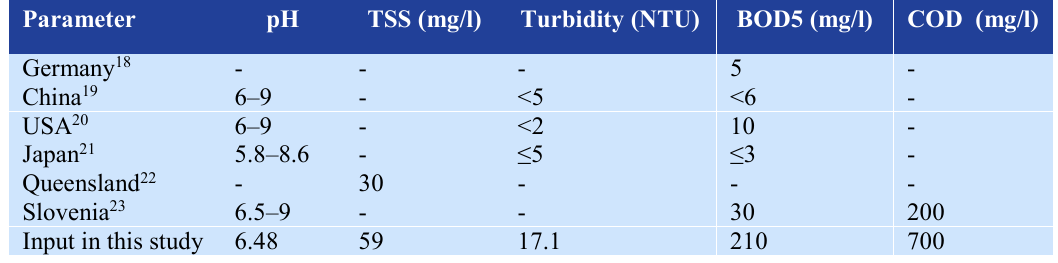
Table 1. Standards for greywater reuse in different countries and contents in entrance